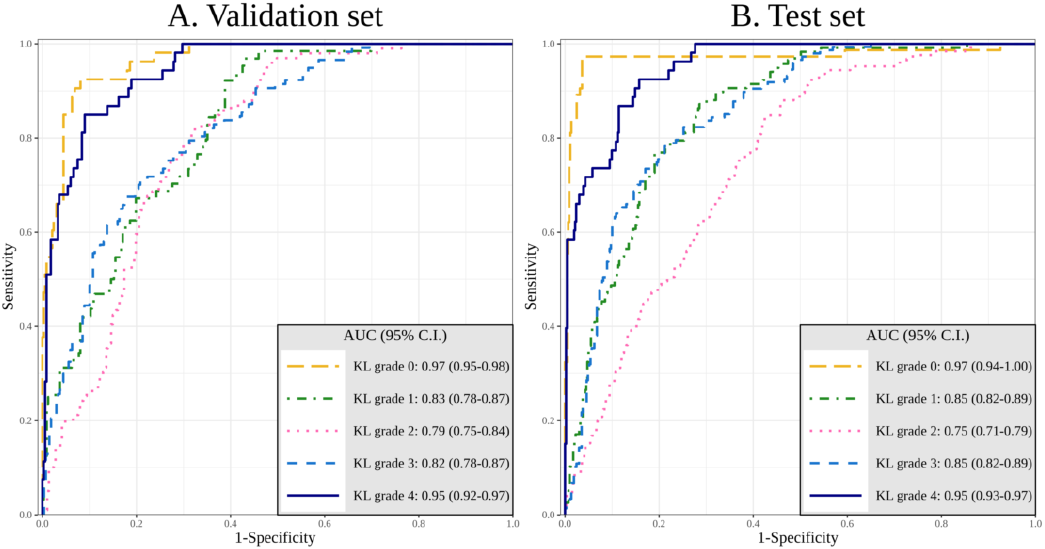
Figure 2. Area under the receiver operating curve of the validation set ( A ) and the test set ( B ) for the DL algorithm of KL grade 0 to 4 with image data and additional patient information.